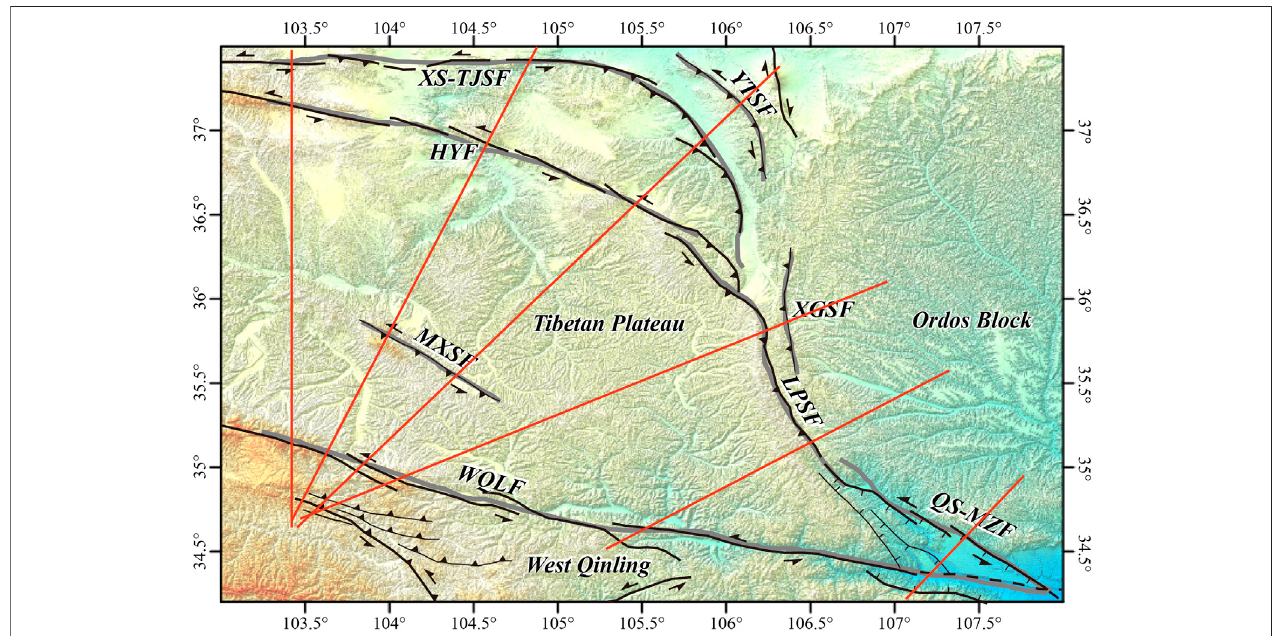
FIGURE 11 | Figure cut pro fi le distribution of the V3 model. Red solid lines represent the locations of pro fi les.